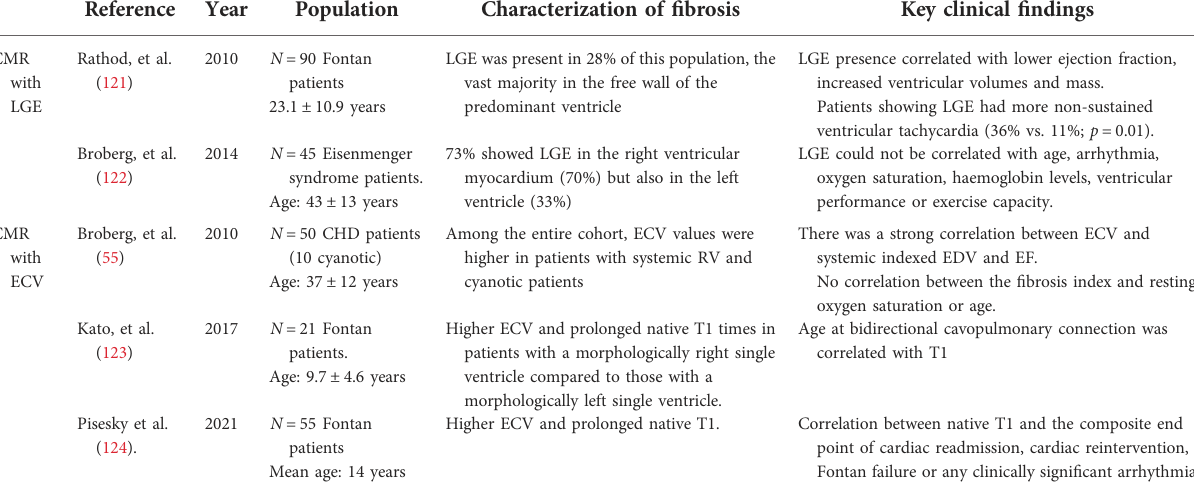
TABLE 4 Most relevant studies characterizing myocardial fi brosis in patients with chronic cyanosis, Eisenmenger syndrome and Fontan